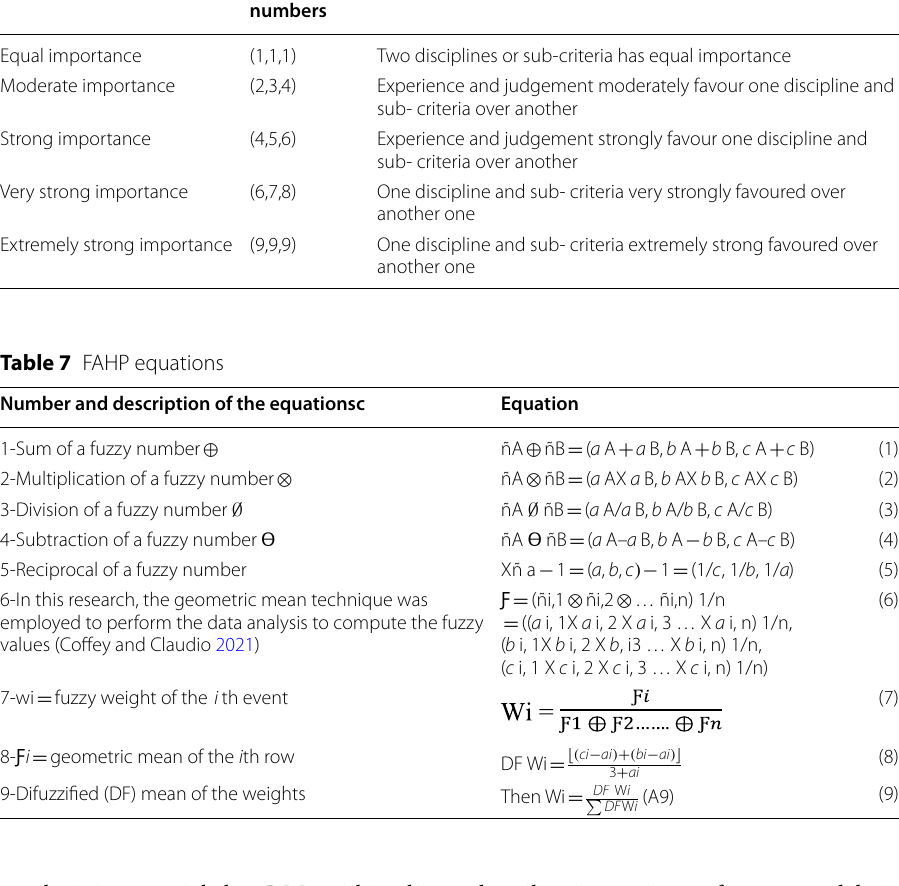
Table 6 The linguistic scale of importance Linguistic scale